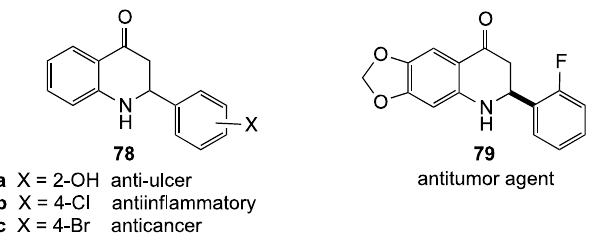
Figure 3. Drugs incorporating 2,3-dihydro-4(1 H